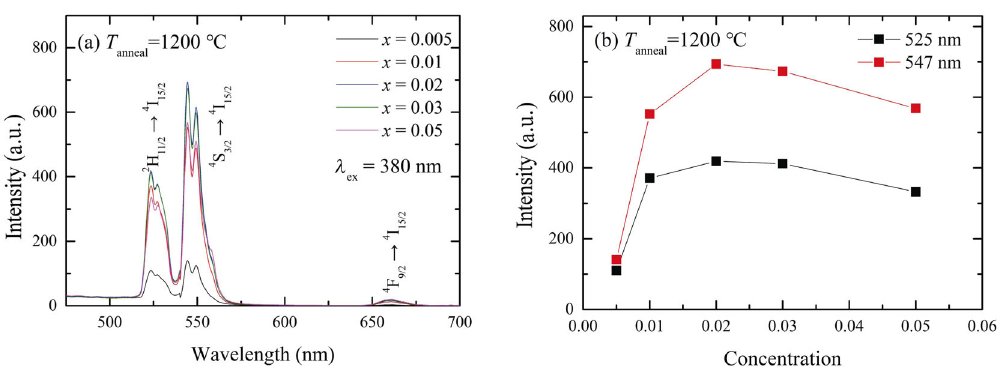
Fig. 6 (a) PL spectra of the x = 0.005, 0.01, 0.02, 0.03, and 0.05 NCs annealed at 1200 ℃ under the λ ex = 380 nm photoexcitation. (b) Emission intensities at 525 and 547 nm of the NCs annealed at 1200 ℃ as a function of the Er 3+ concentration.